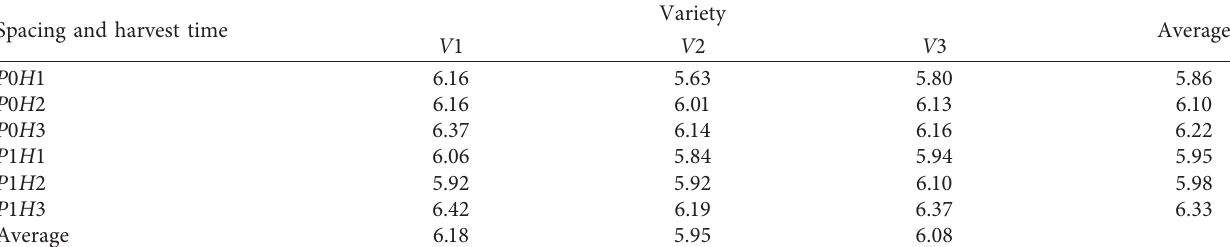
Table 5: Cob diameters (cm) of sweet corn plants of different varieties and at different harvest